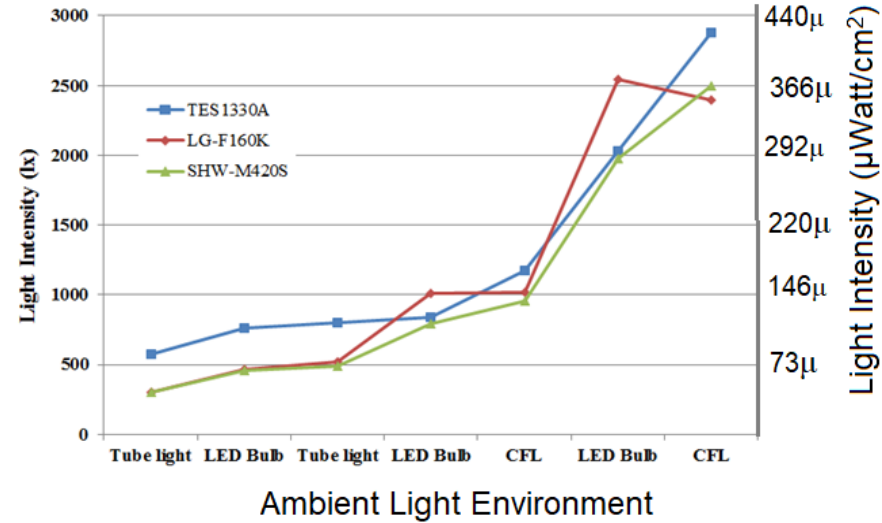
Figure 5. A comparison of smartphone internal ALS data vs. light meter data.